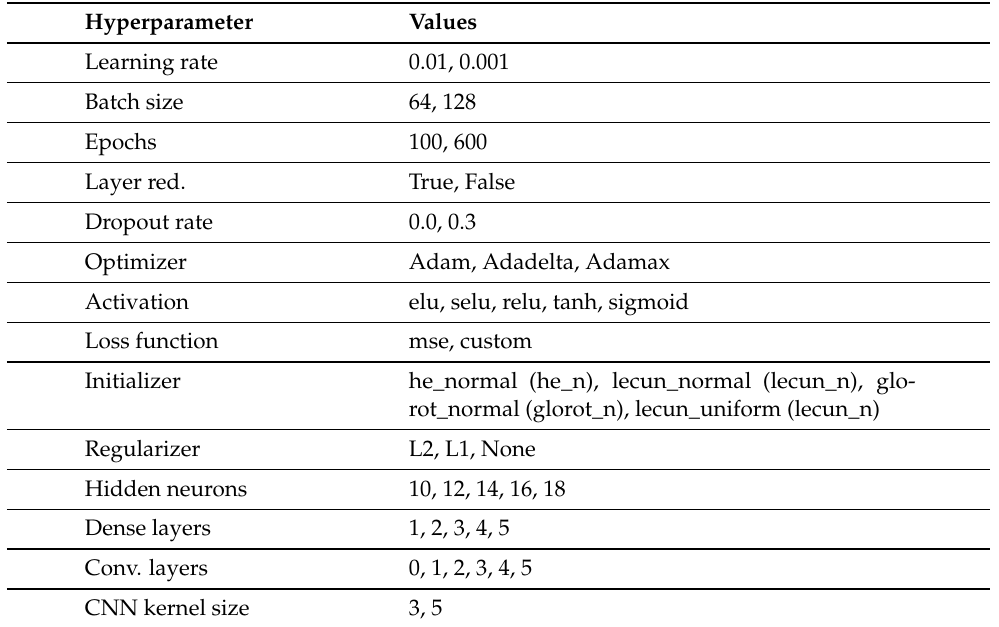
Table 3. Parameter used for model